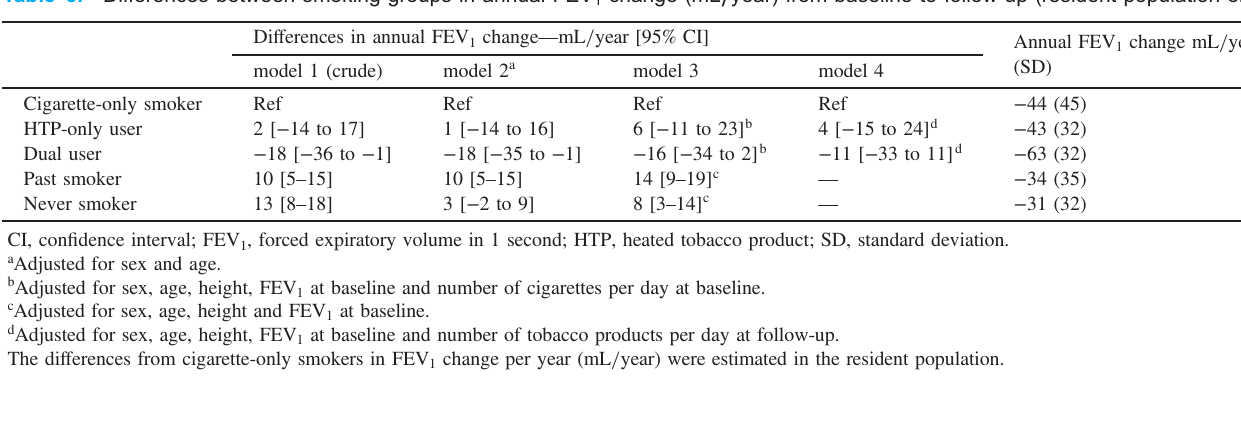
Table 5. Di ff erences between smoking groups in annual FEV 1 change (mL / year) from baseline to follow-up (resident population